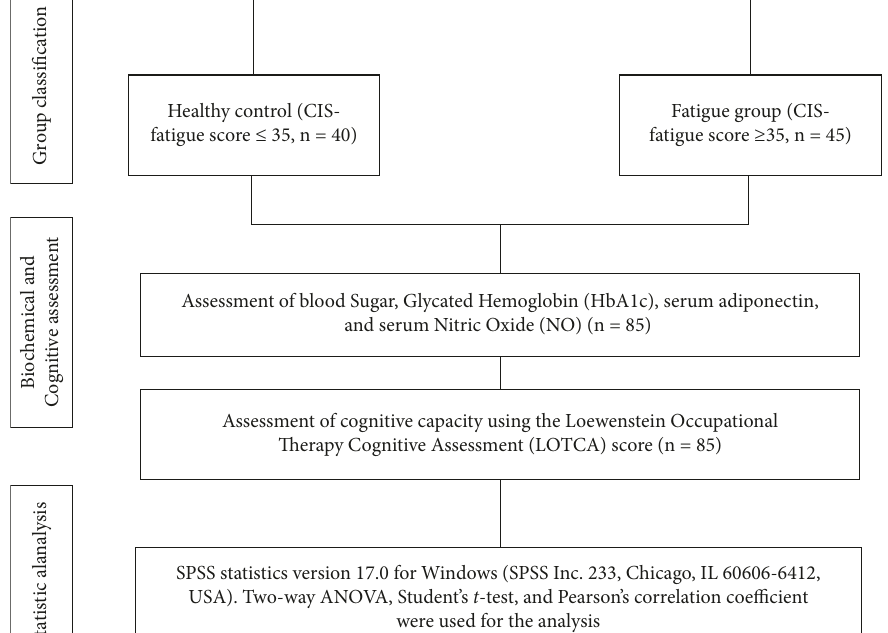
Figure 1: Outline of study